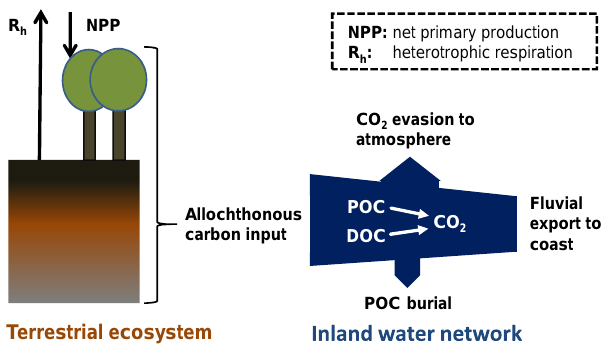
Figure 1. Representation of C exports from terrestrial ecosystems through the land–ocean aquatic continuum